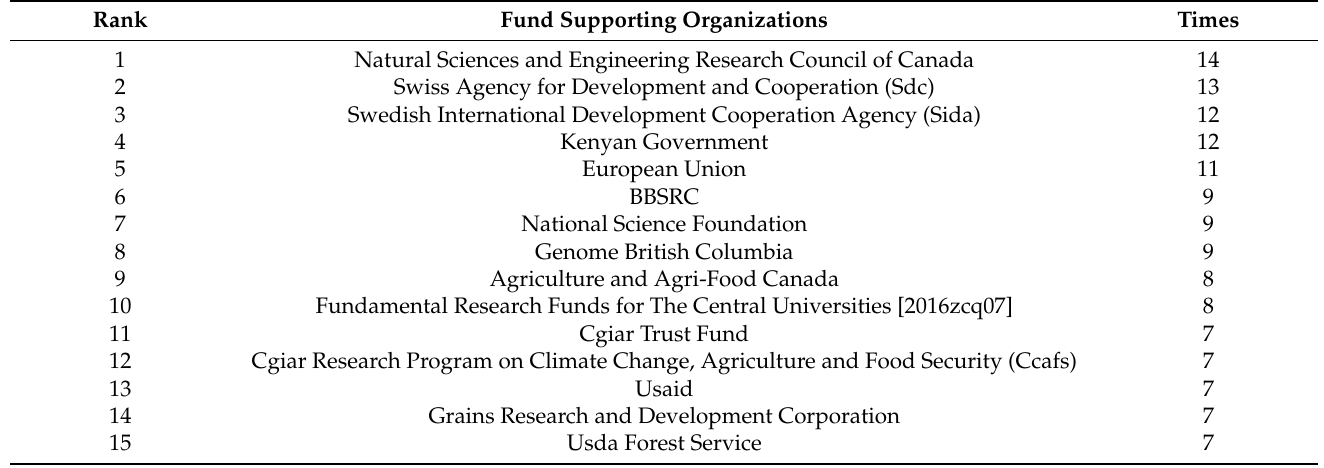
Table 5. Top 15 funding institutions.